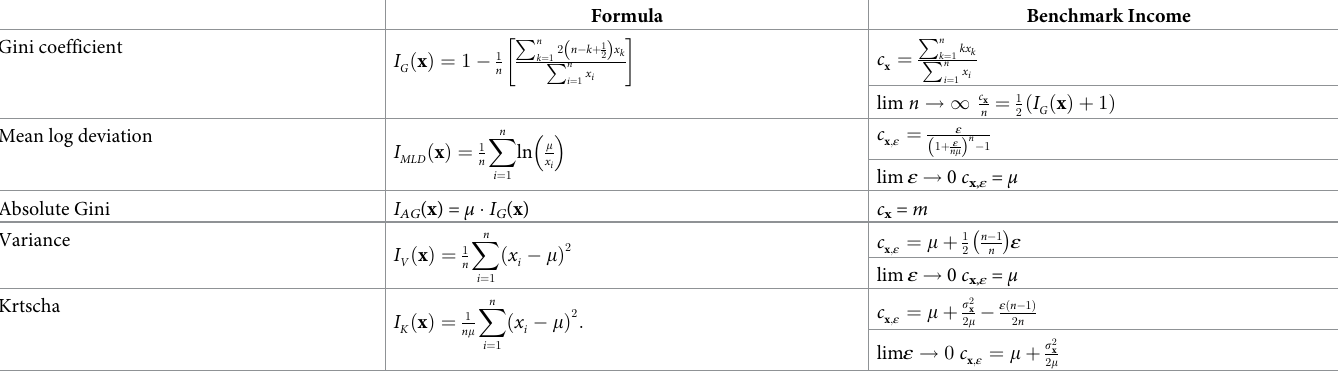
Table 1. Inequality measures and corresponding benchmark